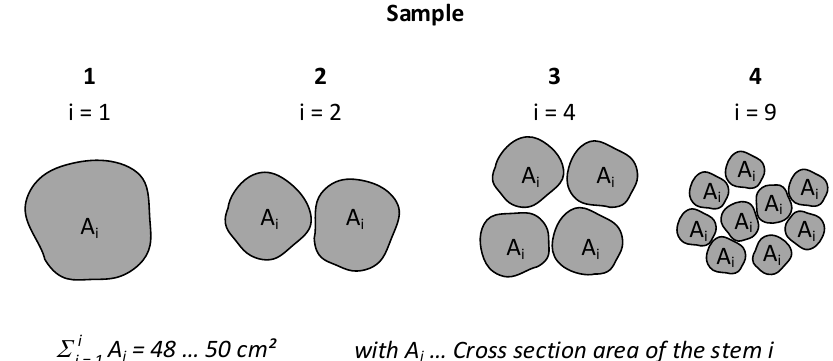
Figure 4. Method for arranging chipping samples with the same cross section area.